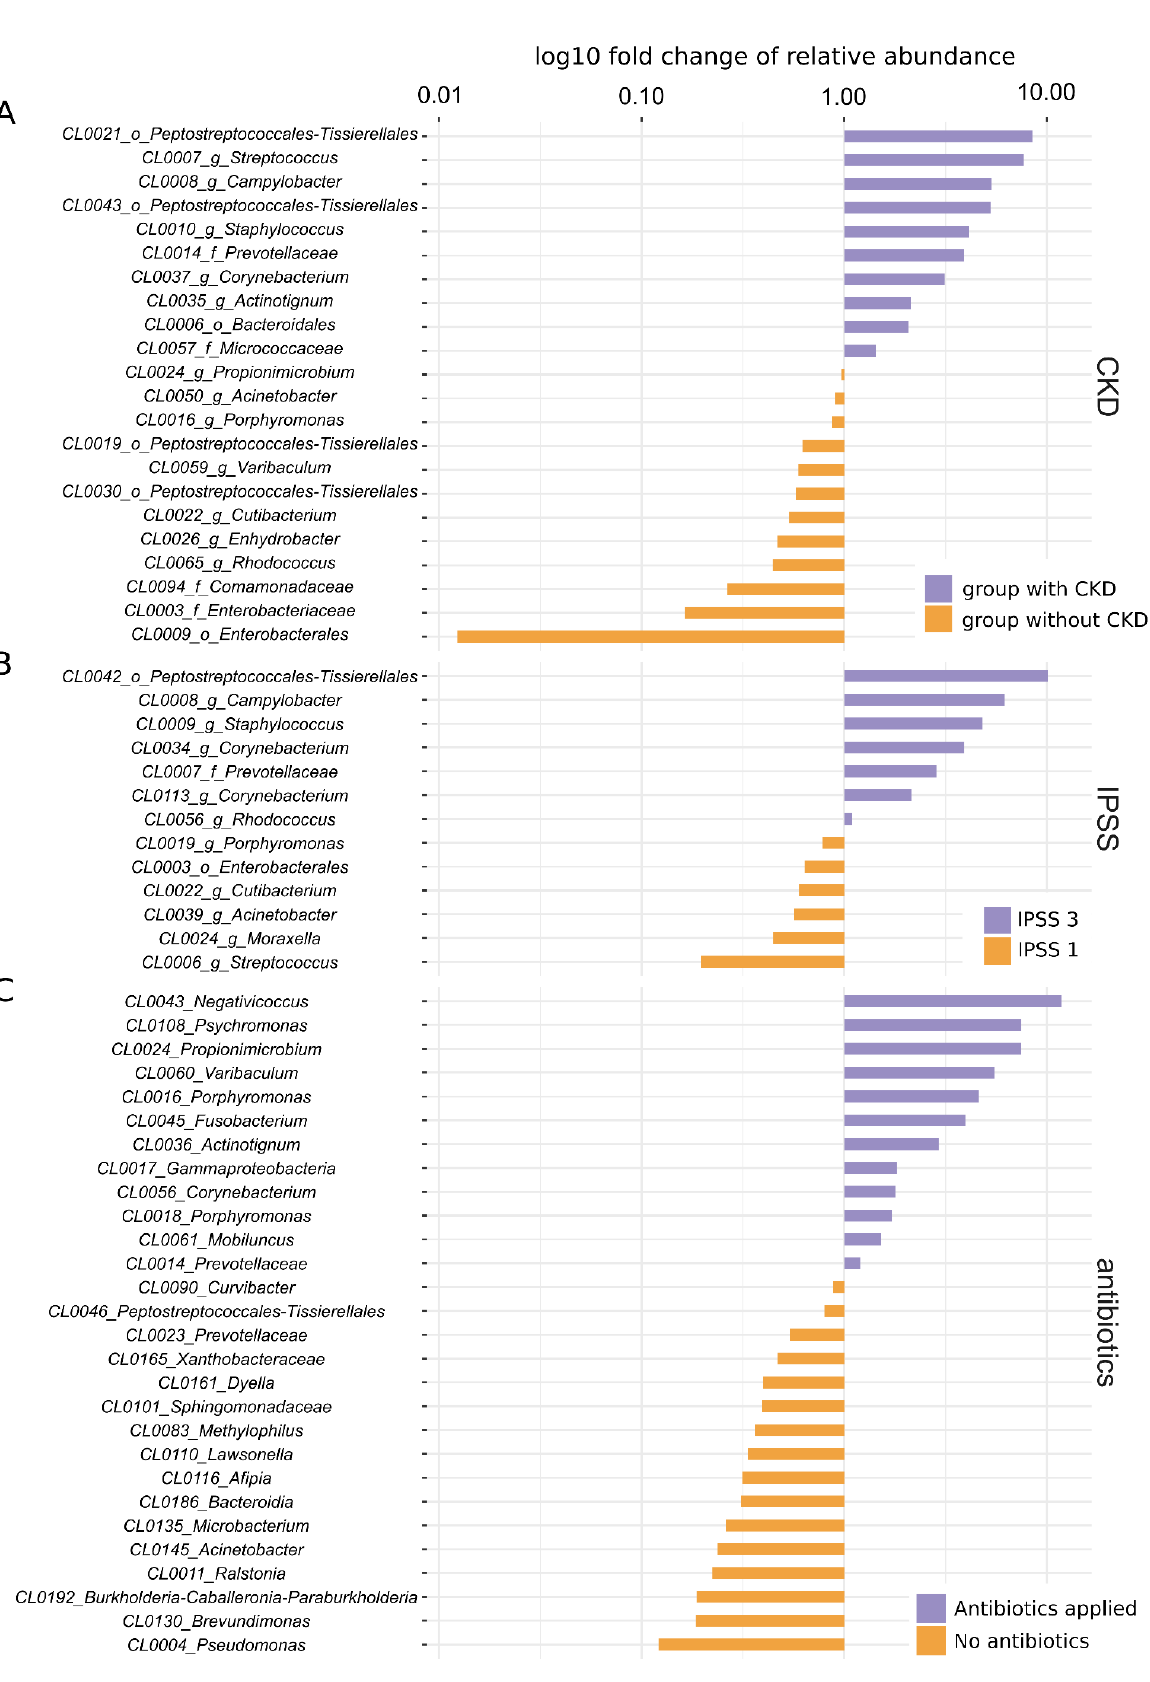
Figure 2. Key OTUs and their distribution in individual groups of patients. ( A ) Key OTUs for patients with CKD and without CKD. ( B ) Key OTUs for patients with IPSS 3 and IPSS 1. ( C ) Key OTUs